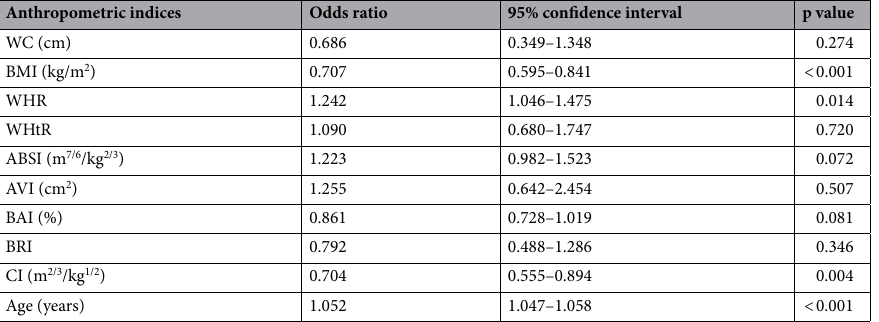
Table 6. Logistic regression for independent determinants of hypertension (≥ 140/90 mmHg). Nagelkerke r 2 = 0.185, p < 0.001 for model fit. Model included all gender specific anthropometric cut off levels as determined in the ROC analysis with adjustment for age. WC waist circumference, BMI body mass index, WHR waist-to-hip ratio, WHtR waist to height ratio, ABSI a body shape index, AVI abdominal volume index, BAI body adiposity index, BRI body roundness index, CI conicity